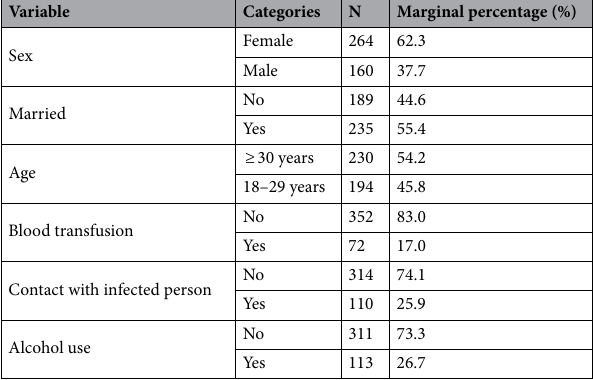
Table 1. Summary of the sociodemographic characteristics of the study participants.